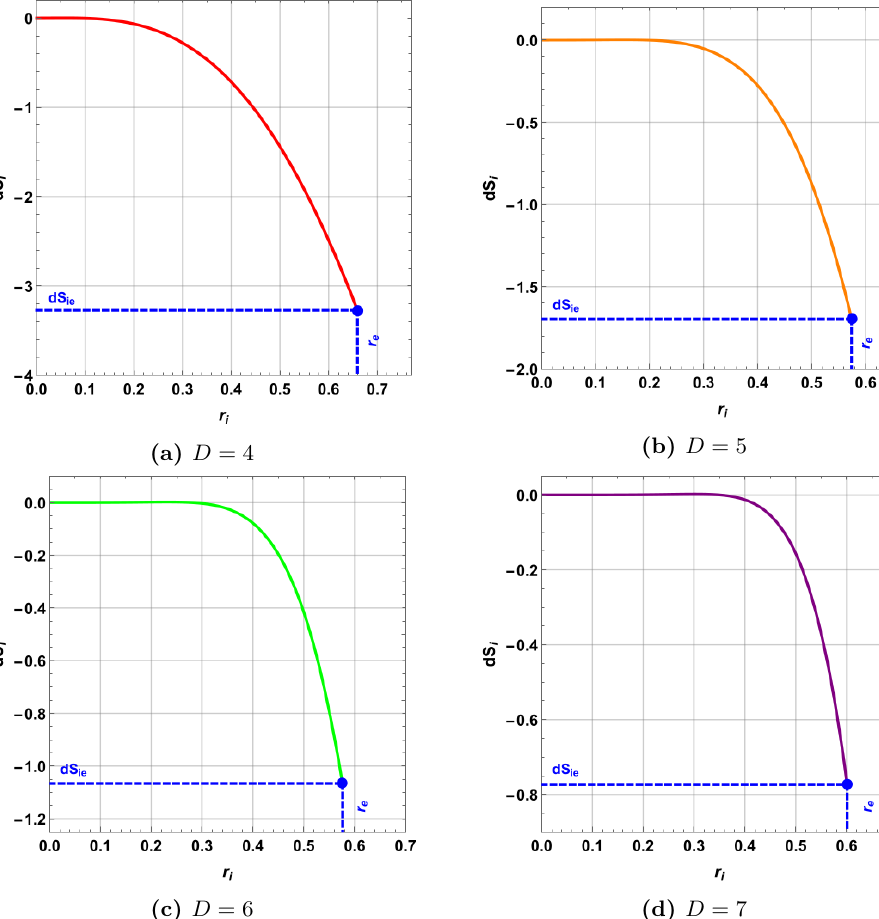
Figure 19. Inner entropy variation dS i as a function of inner horizon radius r i for different dimensions with | p r | = 1 , Q = 1 , l = 1 and dQ = 0 . 1 . The event horizon is fixed to the extremal h